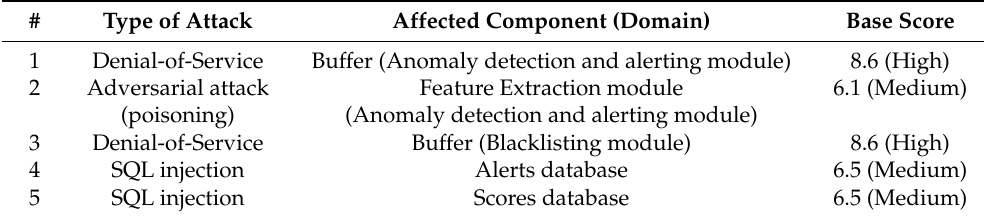
Table 4. Exploitation probability scores for the extended system.